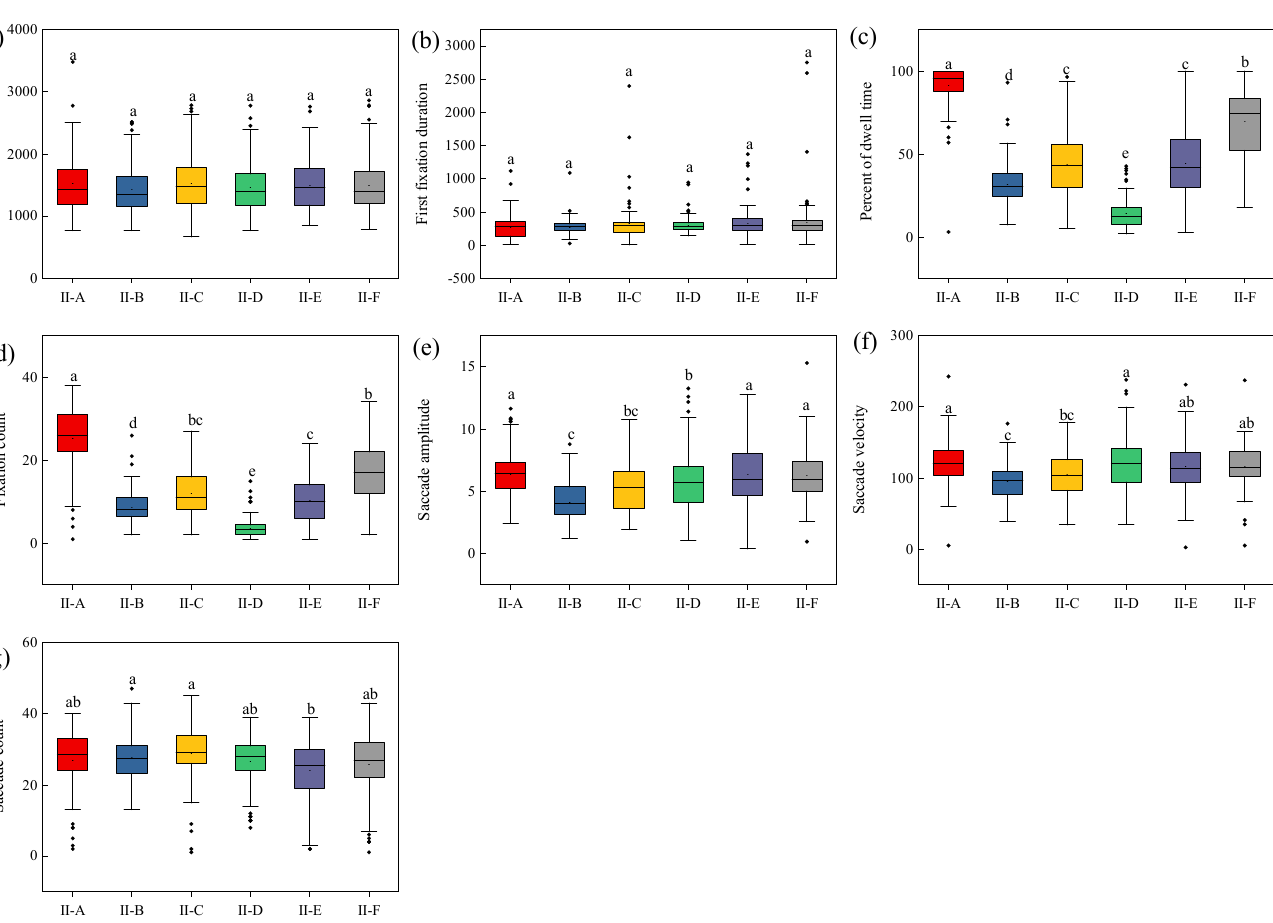
Figure 4. The eye-tracking measures of flower color are shown; ( a – g ) represent pupil size, first fixation duration, the percentage of dwell time, fixation count, saccade amplitude, saccade velocity, and saccade count, respectively; II-A–II-F represent blue, red, pink, purple, white, and yellow flowers, respectively. Different lowercase letters indicate significant differences among different attributes with the same category ( p < 0.05). Little square represents the mean and rhombus filled with black represents outliers.